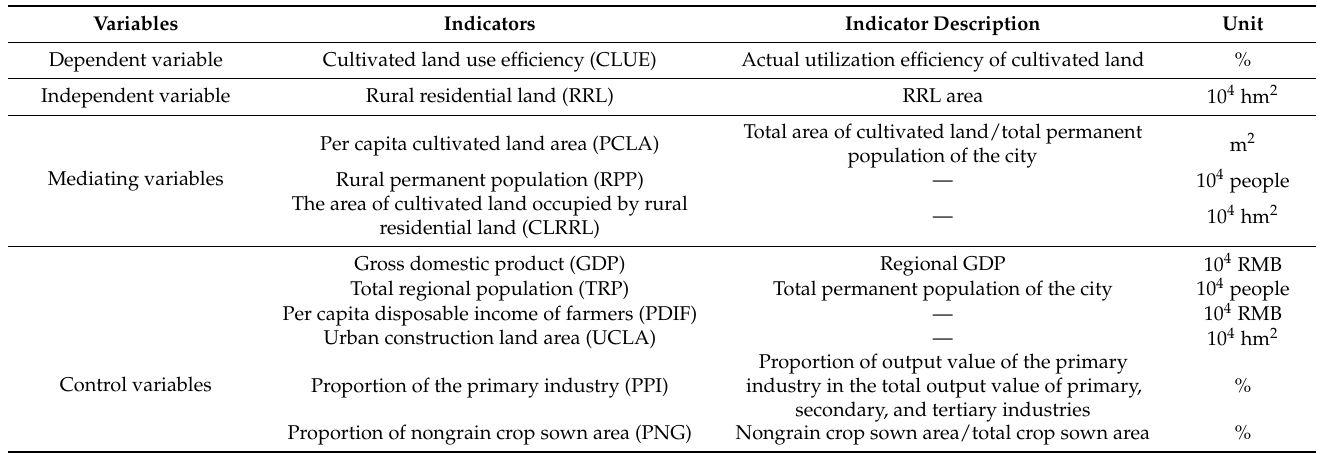
Table 2. Impact indicators of RRL use change on